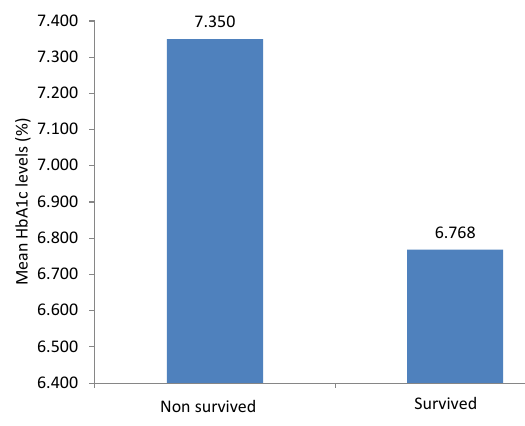
Figure 2 . The comparison of HbA1c in the patients who survived and expired at the end of one year after the measurement ( P =